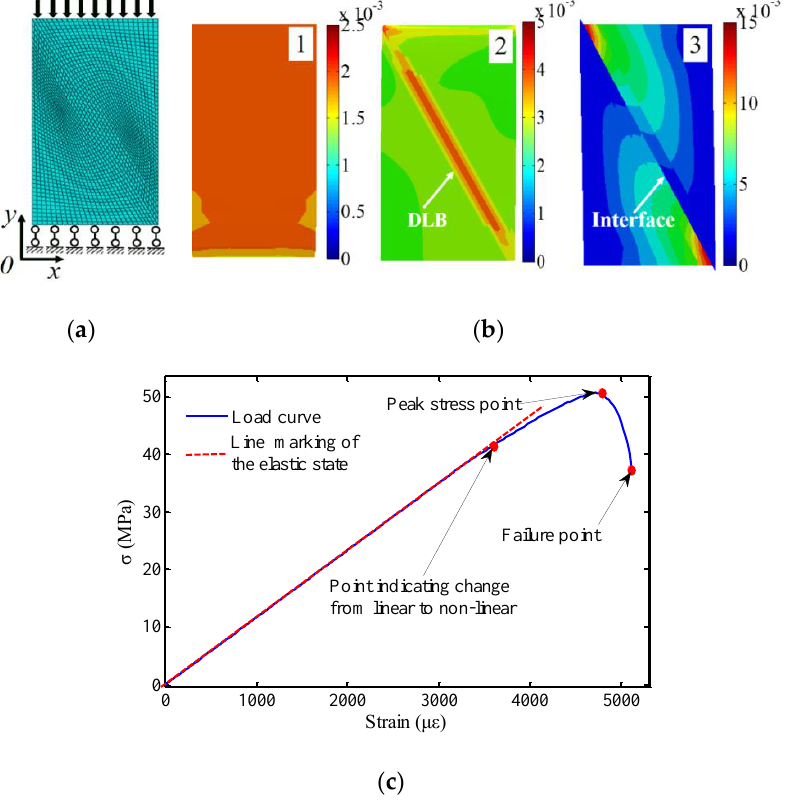
Figure 6. Model and simulation results: ( a ) Numerical model; ( b ) shear strain field obtained using the FEM; ( c ) load curve obtained using the FEM.